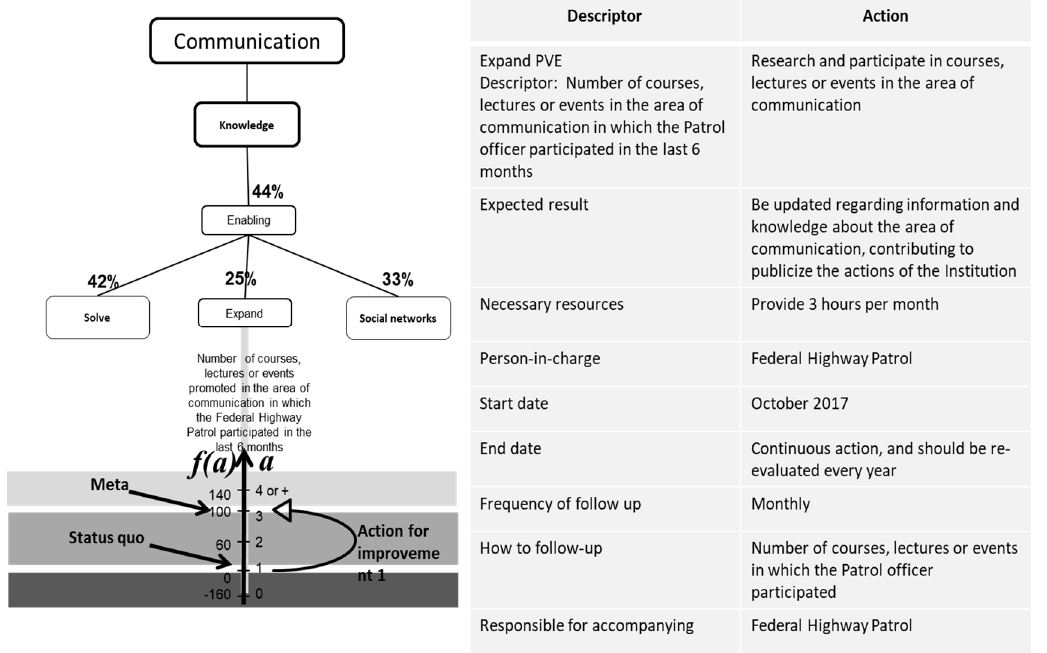
Figure 6. Highlight of the descriptors that will undergo improvement actions in the recommenda- tions phase.